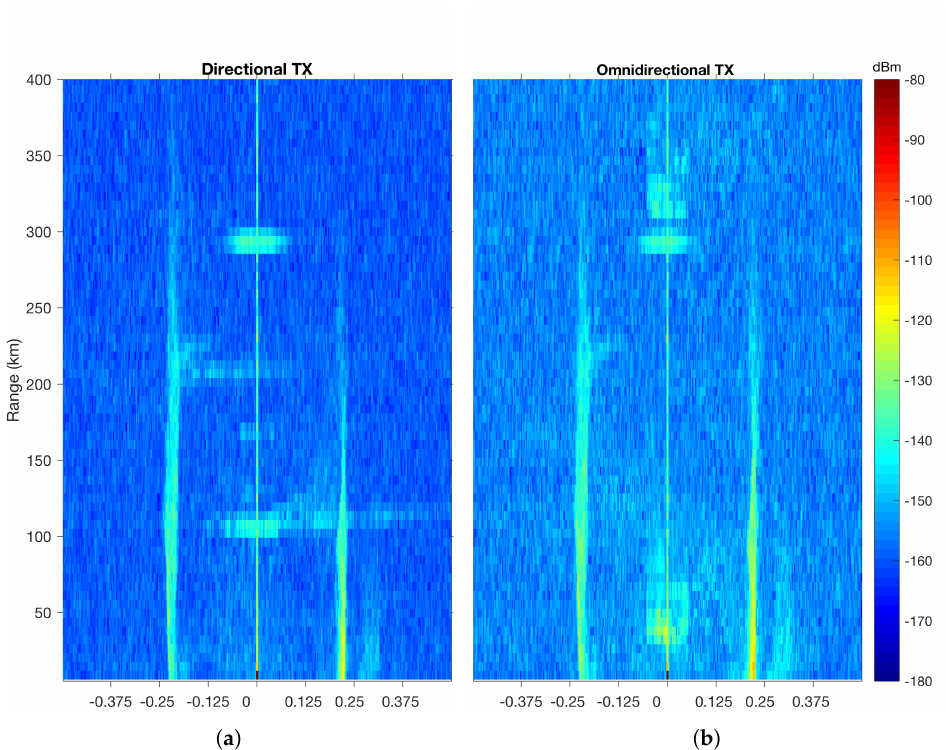
Figure 7. Examples of Range Doppler spectra at Lancelin SeaSonde station, collected through receiver channel 3, using the prototype directive antenna with improved design ( a ); and using the conventional transmit antenna ( b ). Signal power is expressed in dBm. Range is given in km offshore vs. Doppler frequency in Hz. Range resolution is 5.7 km at 26 kHz bandwidth. Doppler spectra were collected on 20 December 2018, at 0700 and 0930 Universal Time Coordonné (UTC), respectively. Integration time was consistent between the two